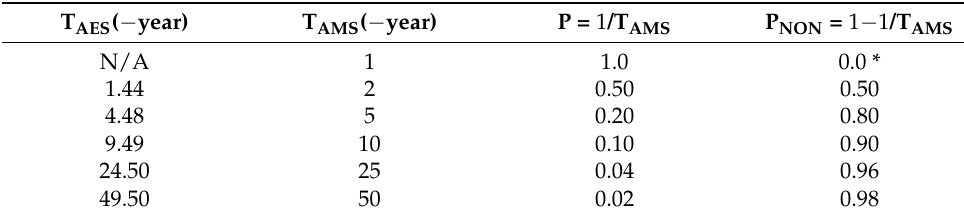
Table 1. Return periods based on AMS